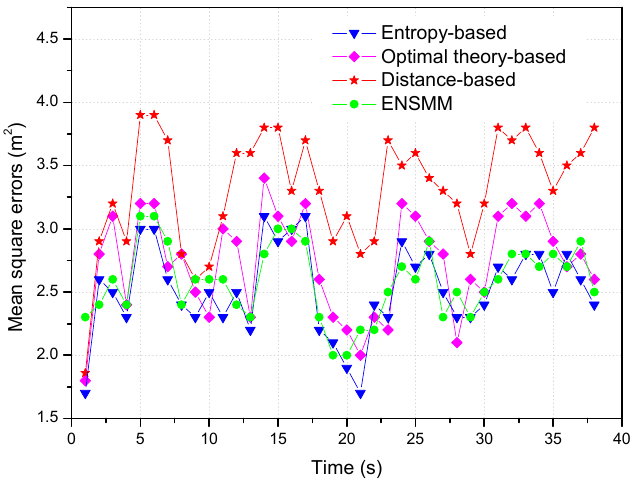
Figure 8. Mean square positioning errors in different methods.